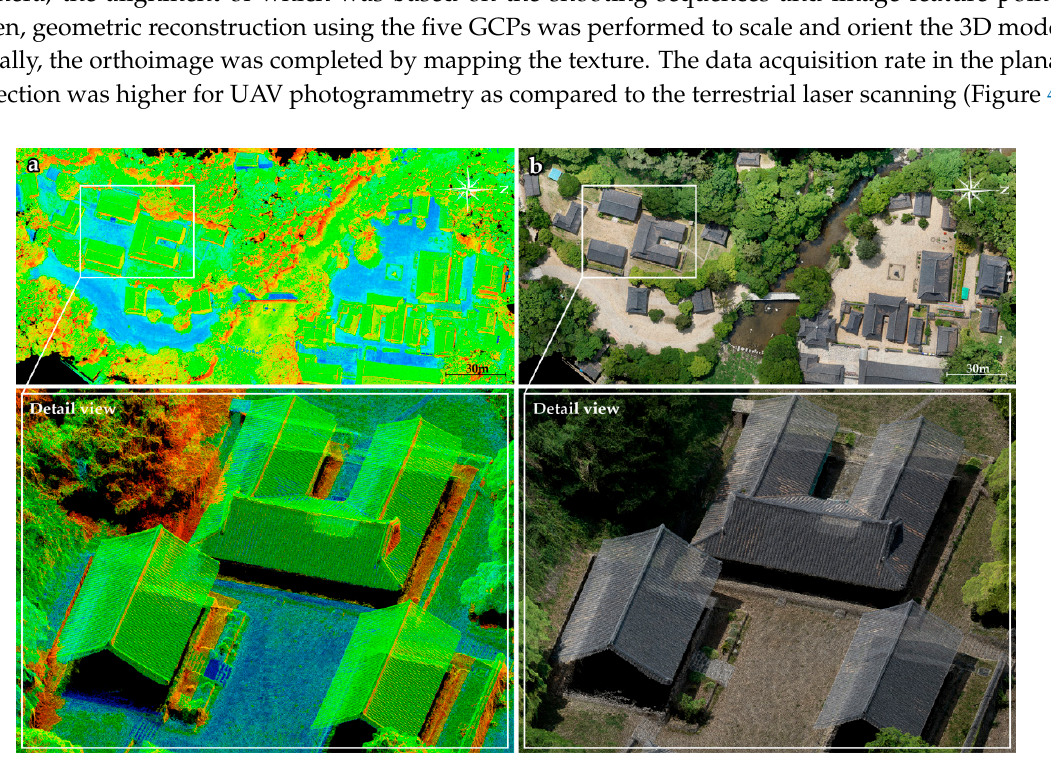
Figure 4. Orthoimage and detailed view of the Magoksa Temple created via UAV photogrammetry: ( a ) density image; ( b ) RGB texture mapping image.